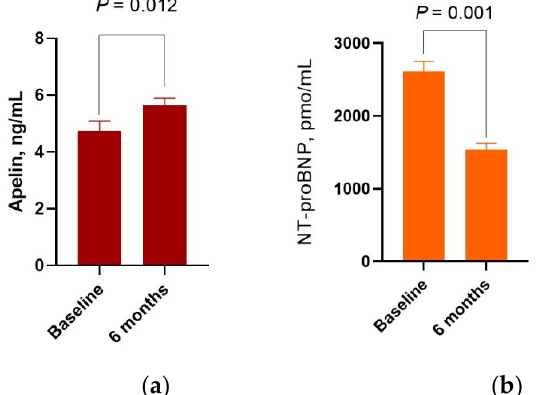
Figure 2. Bar graphs at baseline and 6 months after dapagliflozin administration, showing significant increase in serum levels of apelin ( a ) and decrease in NT-proBNP ( b ).